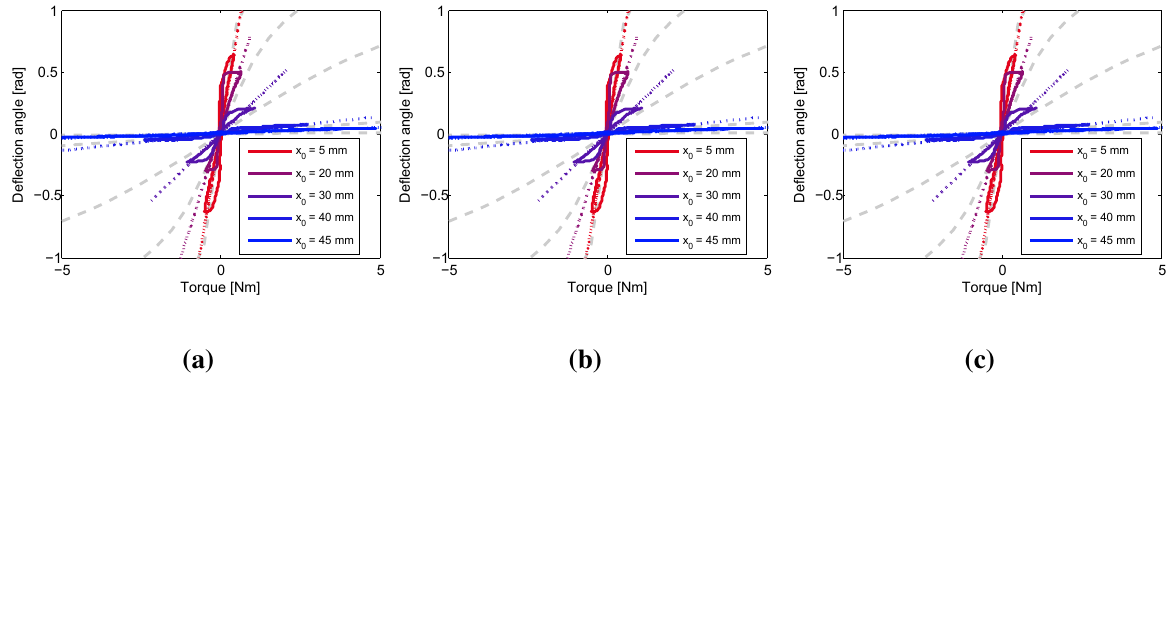
Figure 17. Deflection/torque measurement results using a double-leaf spring (for clarity, only half of the measurements are shown). The dashed line represents the simulated deflection/torque data, and the dotted line is the linear least squares approximation to the deflection/torque data. ( a ) Uniform; ( b ) negative parabola; ( c ) positive